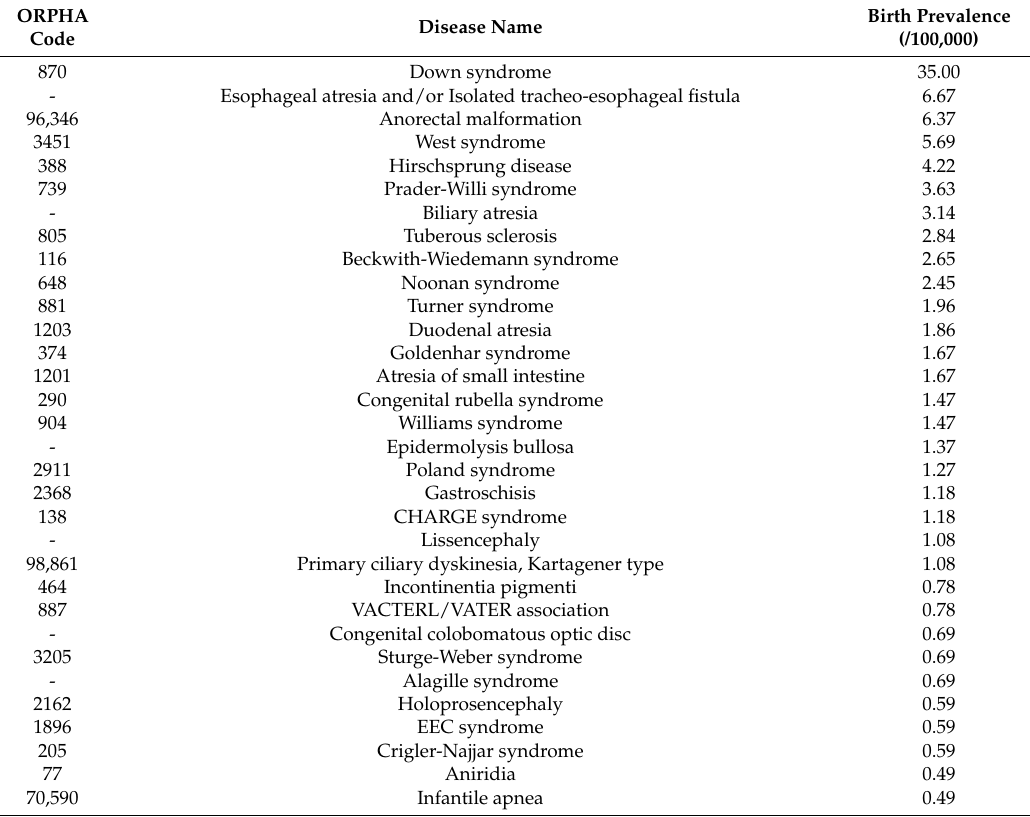
Table 4. National BP Rates of most birth-prevalent rare diseases and rare disease groups monitored by RNMR in the Italian population. Rates in live births of the two-year period